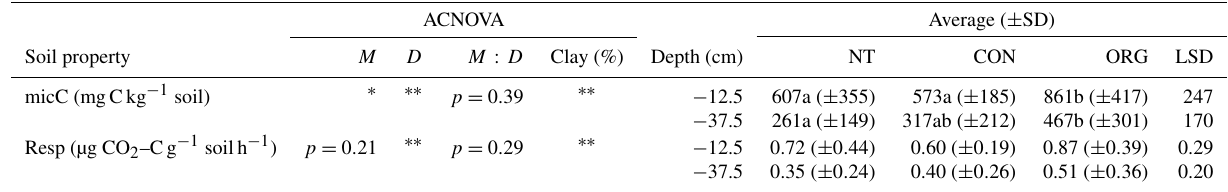
Table 3. Effects of management system ( M ), sampling depth ( D ), their interaction ( M : D ), and clay content on soil organic carbon, microbial biomass, and microbial respiration, analysed with linear mixed models (Eq. 2) followed by analysis of covariance (ANCOVA). ∗∗ and ∗ indicate significant effects at p< 0 . 01 and < 0 . 05, respectively. Average values for the different depths represent means for no-till (NT), conventional (CON), and organic (ORG) soil management system. Different letters indicate significant differences between management systems at individual depths using least significant difference (LSD) tests at p< 0 . 05 ( n = 10).